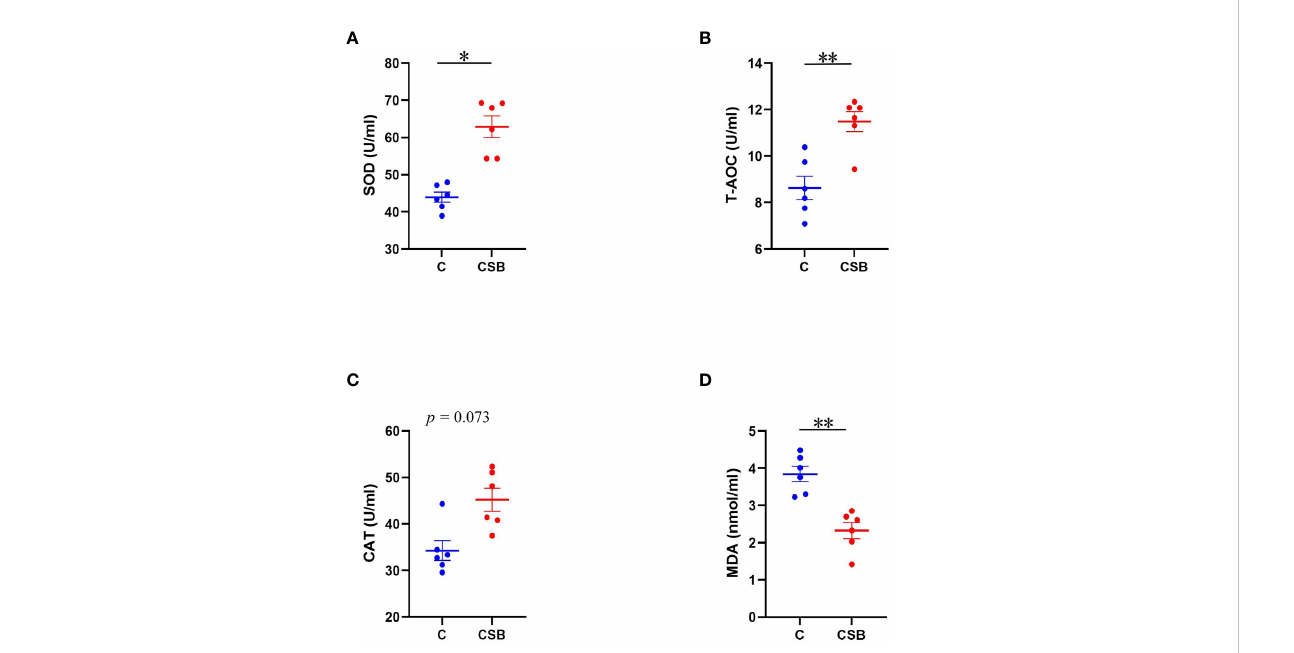
FIGURE 2 Effects of dietary supplementation of coated sodium butyrate (CSB) on the serum antioxidant status of laying ducks. (A) Superoxide dismutase (SOD). (B) Total antioxidant capacity (T-AOC). (C) Catalase (CAT), and (D) Malondialdehyde (MDA). Values are presented as means ± SEM (n = 6). * p< 0.05 and ** p< 0.01. group C, Control group, which was fed a basal diet; CSB group, CSB-treated group, which was fed the basal diet supplemented with 250 g/t of